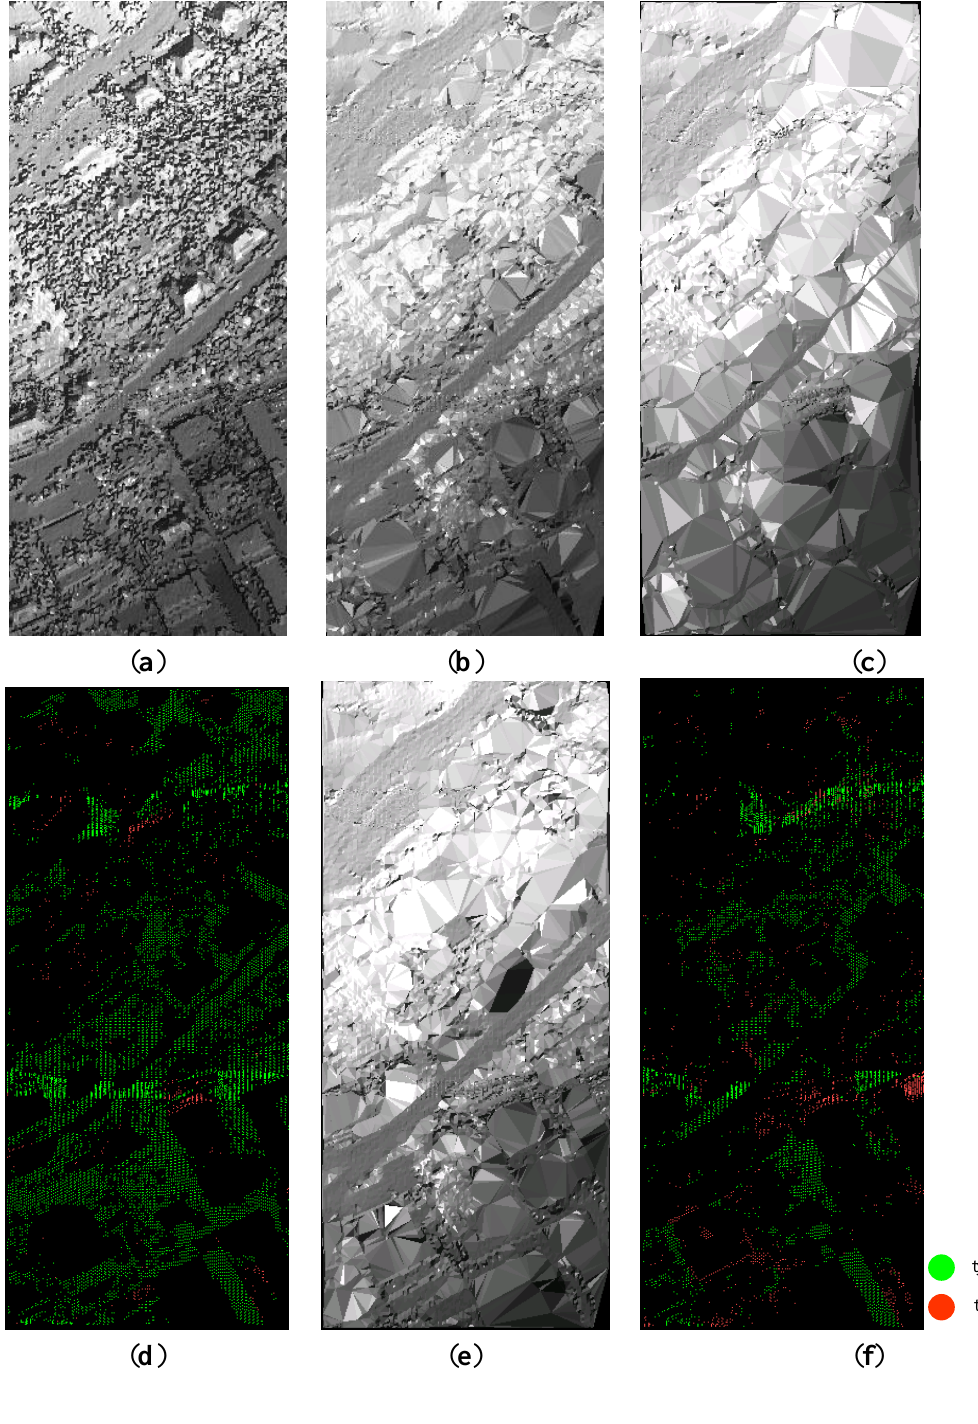
Figure 7. Filtering and results of reference data of Sample 11: ( a ) The digital surface model (DSM); ( b ) The reference DEM; ( c ) The DEM generated from the result of the PTD method; ( d ) The type I errors, type II errors of the PTD method; ( e ) The DEM generated from the result of the SBF method; ( f ) The type I errors, type II errors of the SBF method. Note that both of the DSM and the DEM are